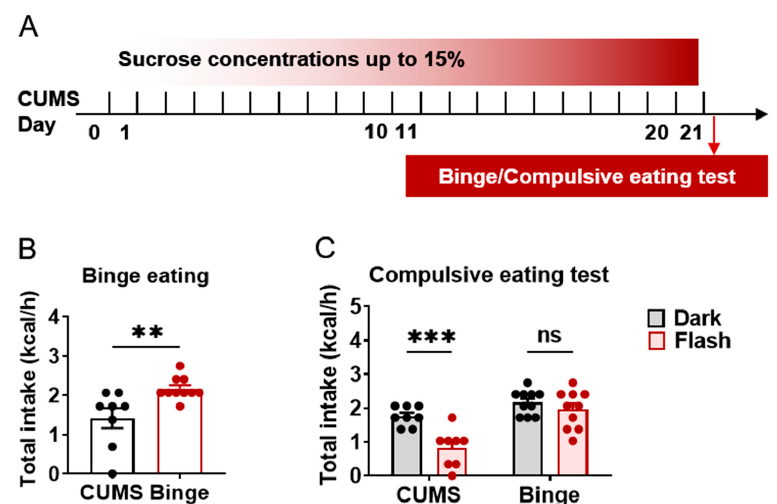
Figure 5. Binge phenotype observed in sucrose-treated group. ( A ). Schematic of cue-paired sucrose solution-induced cue preference. ( B ). Total chow intake of C57BL/6J mice within 1 h. ( C ). Total chow intake of C57BL/6J mice under dark or flashing light to measure compulsive eating. N = 8–10. Data were analyzed by student t -test and two-way ANOVA and are shown as mean ± SEM. ns, no significant difference, **, p < 0.01. ***, p < 0.001.